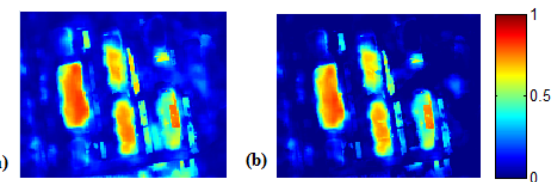
Figure 10. BPM6 (a) and DIFF (b) of the sub-region marked in Figure 8 (a).